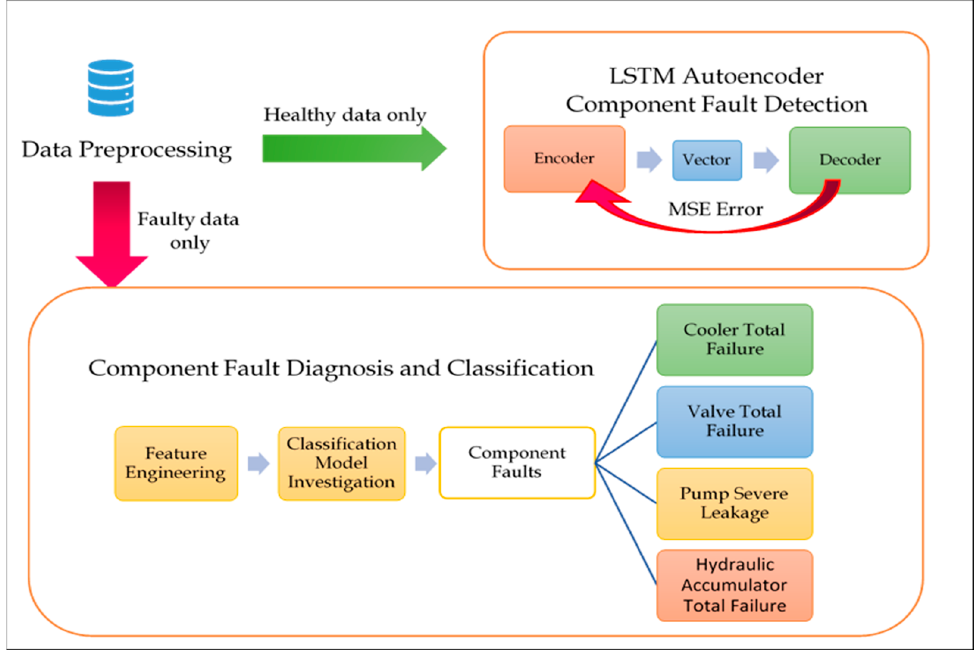
Figure 5. Component FDD Comprehensive